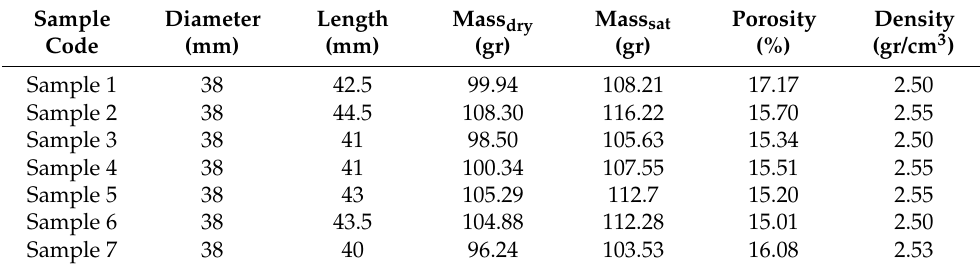
Table 3. Physical properties of the seven sandstone